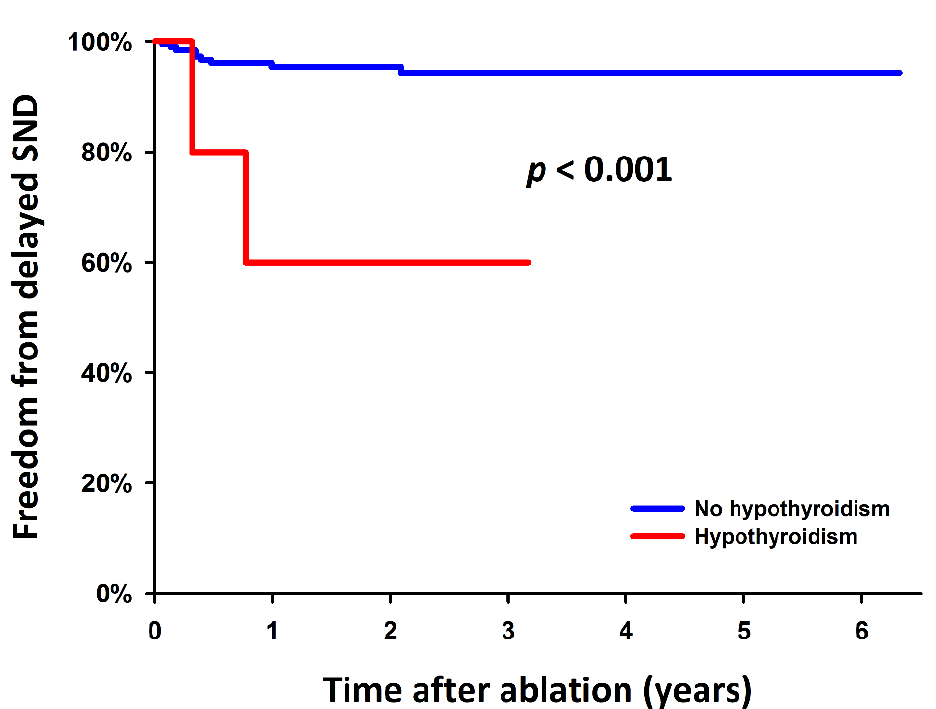
Figure 4. Kaplan–Meier estimates for the delayed SND requiring a PPM after ablation for persistent AFL among patients with and without a history of hypothyroidism, with the statistical significance examined using the Log-rank test. AFL: atrial flutter; PPM: permanent pacemaker; SND: sinus node dysfunction.